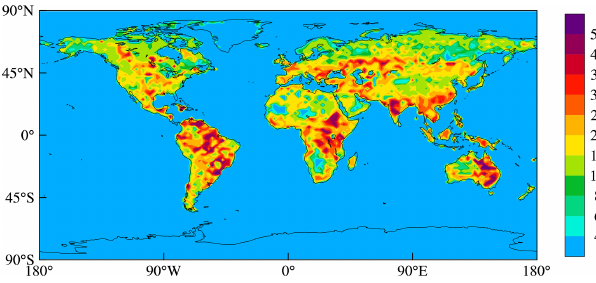
Figure 2. Updated input data of global M clay (%). Data are derived from Shangguan et al. (2014) and are re-gridded to 2 ◦ × 2.5 ◦ hori- zontal resolution in the